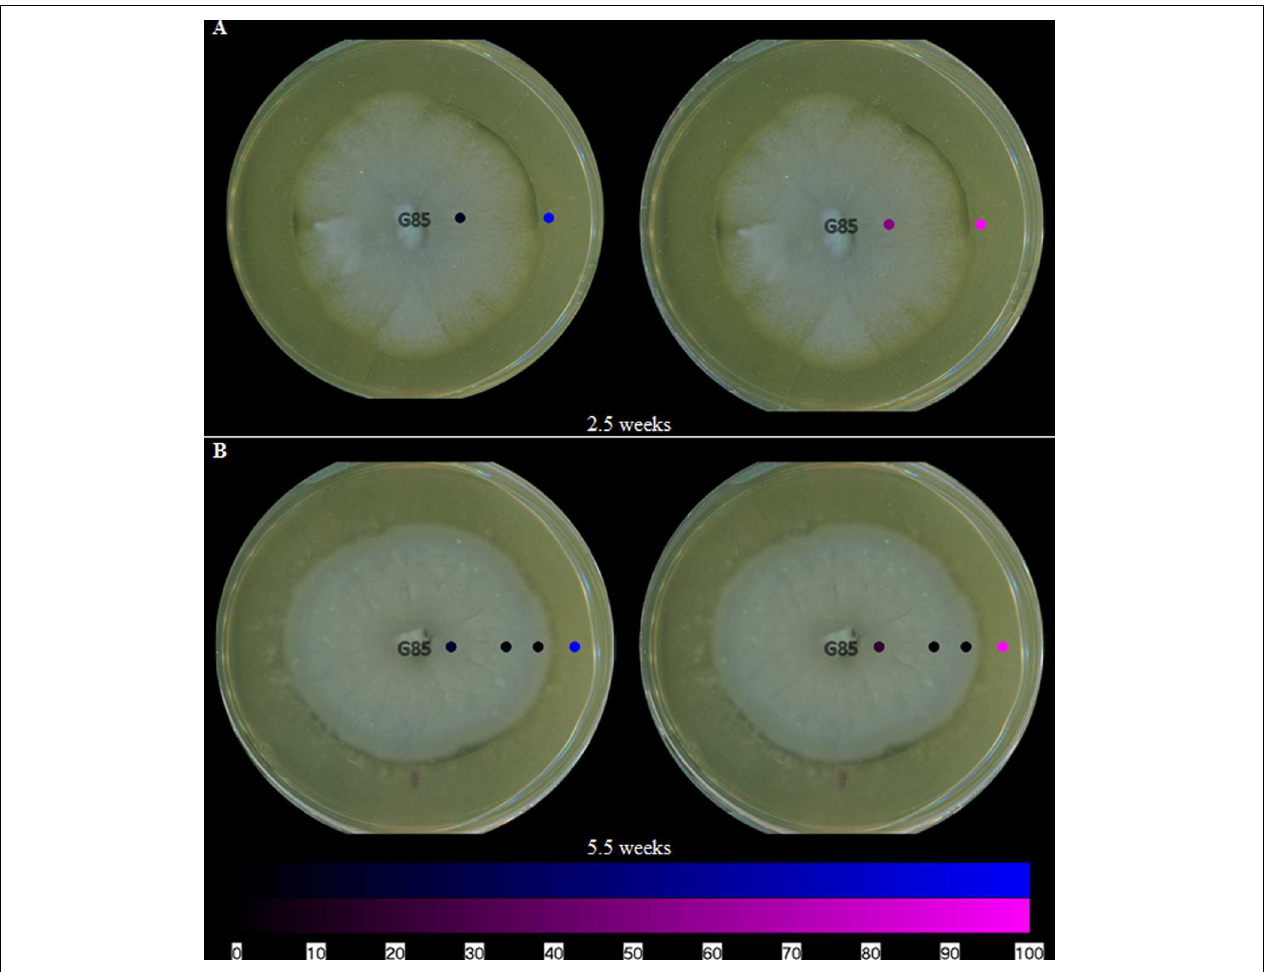
FIGURE 6 | The spatial distribution of both groups of polyhydroxyanthraquinones on fungal isolates of P. restrictum (G85) at (A) 2.5 weeks and (B) 5.5 weeks. The color coding (blue and purple) corresponds to the structures in Figure 1 . Each circle represents a sampled location. The polyhydroxyanthraquinones were most intense where the blue or purple circles were brightest. The bottom bar indicates the relative amount of signal as measured via mass spectrometry.